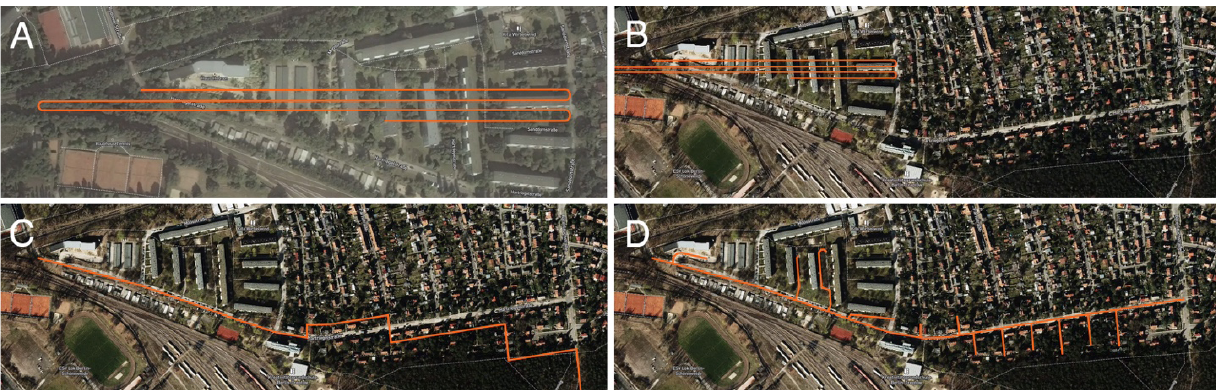
Figure 2. How a street uncoils: a. coiled view on map; b. zoomed out; c. unrolled; d. split up and translation of misplaced parts that previously exceeded the viewport in the bottom right corner—this is the original shape of the street.